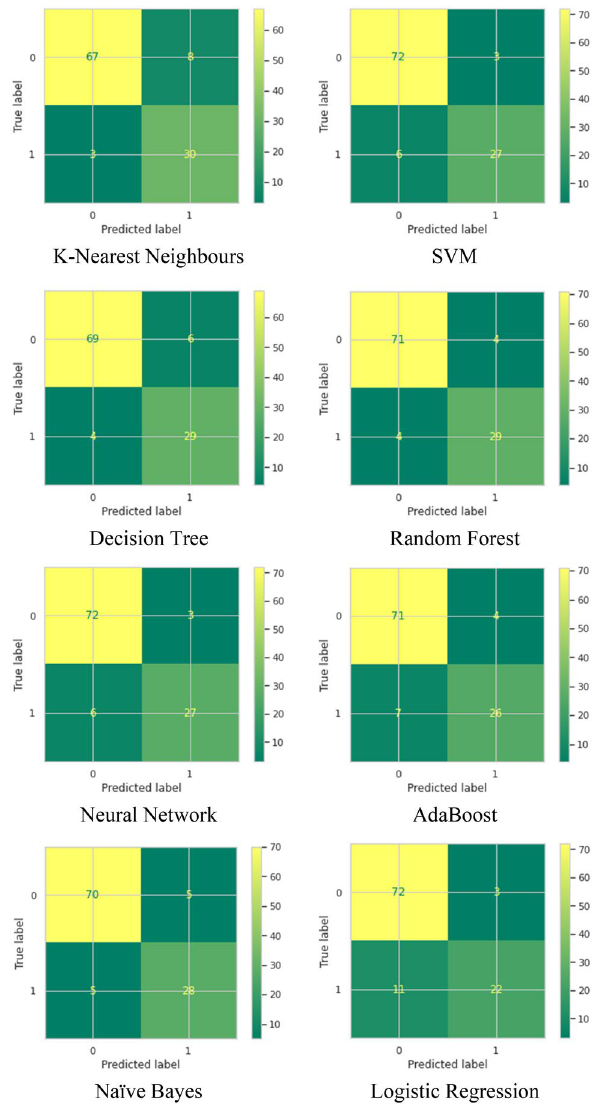
Table 4. Confusion matrix of the eight classification algorithms considered in the